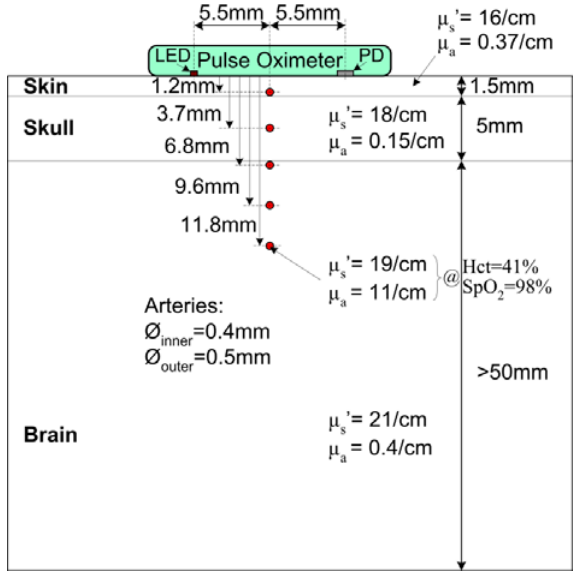
three tissue layers (skin, skull, and brain) and five arteries at different depths. The optical properties (absorption coefficient and reduced scattering coefficient) and physical properties (layer depth, artery diameter) are indicated in the